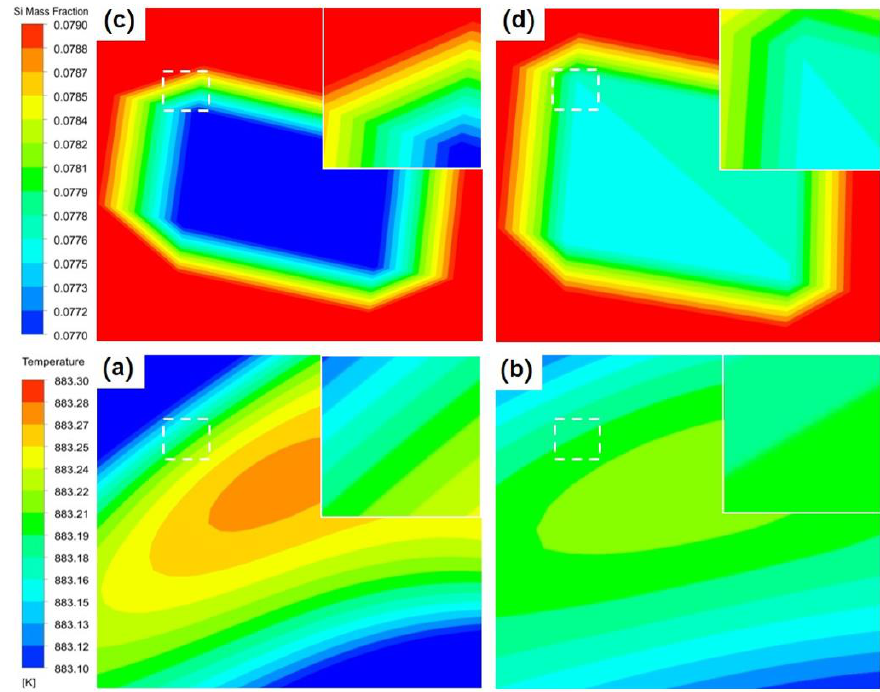
Figure 7. Magnified images of the regions marked in Figures 4c,d and 5c,d. Inserts in ( a )–( d ) are the further magnified images of the corresponding regions marked.